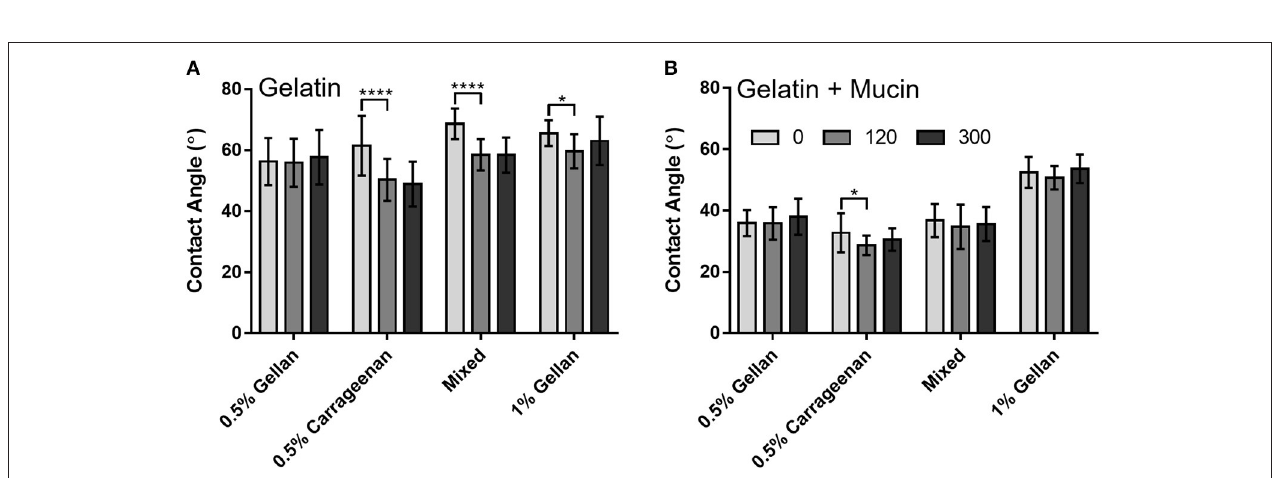
FIGURE 6 | Contact angle measurements of each formulation over time, on (A) gelatin only and (B) mucin gelatin plates. Graphs show mean ± SD ( n = 3), and show the results of a two-way ANOVA with a post-hoc Tukey’s multiple comparisons test.